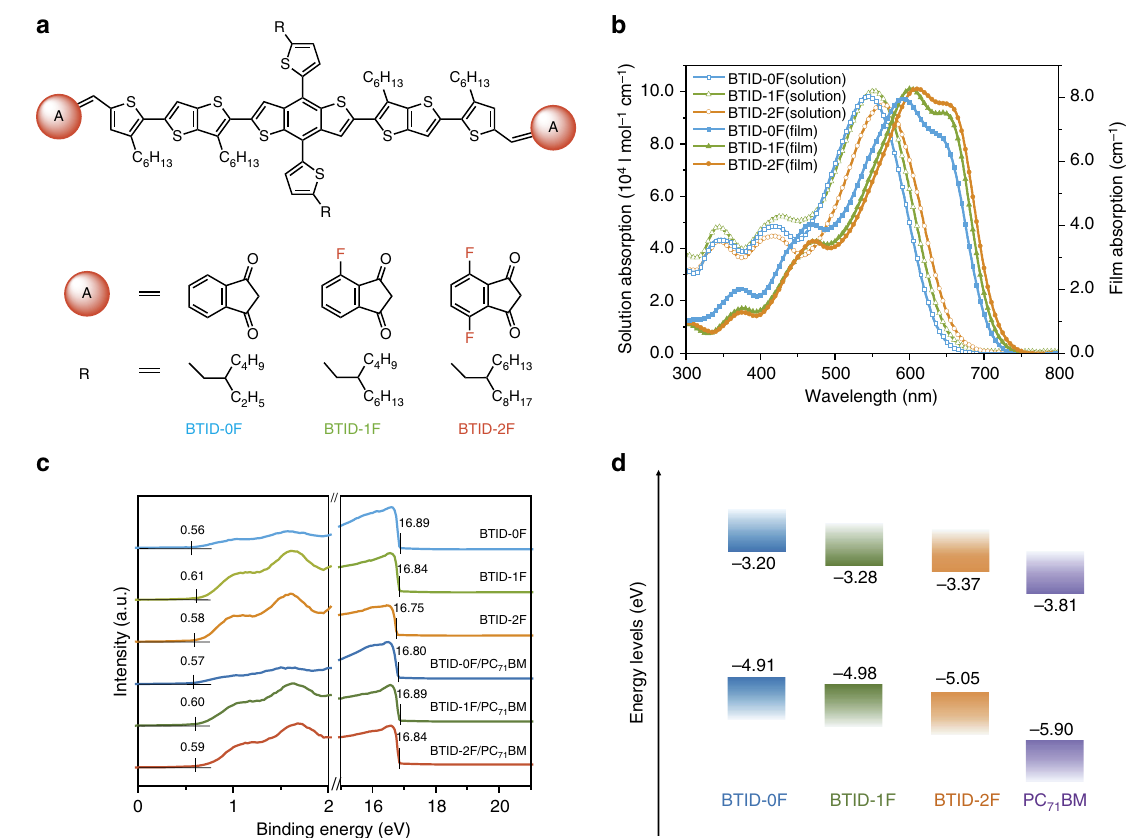
Figure 1 | Molecular structures and properties. ( a ) Small molecular structures; ( b ) solution coefficient of samples in chloroform (left Y axis) and film (right Y axis); ( c ) UPS results of the pristine films and blended films with PC 71 BM; and ( d ) molecular energy levels measured from UPS, the lowest unoccupied molecular orbital (LUMO) levels calculated from optical bandgap and